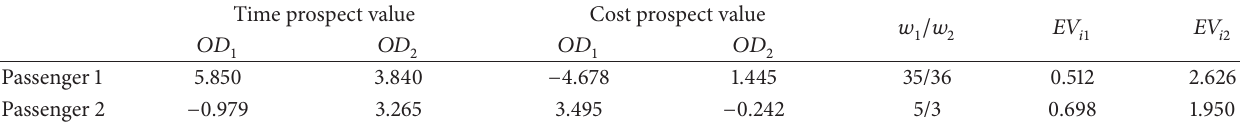
Table 6: Prospect value of scene